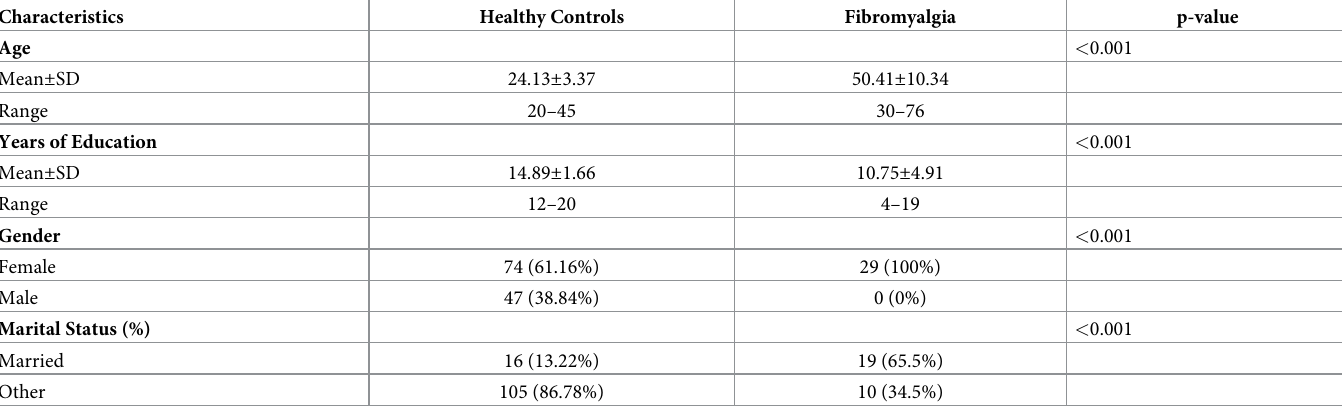
Table 1. Demographic data of the healthy cohort (HC) (n = 122) and Fibromyalgia (FM) (n = 29) cohorts. Characteristics